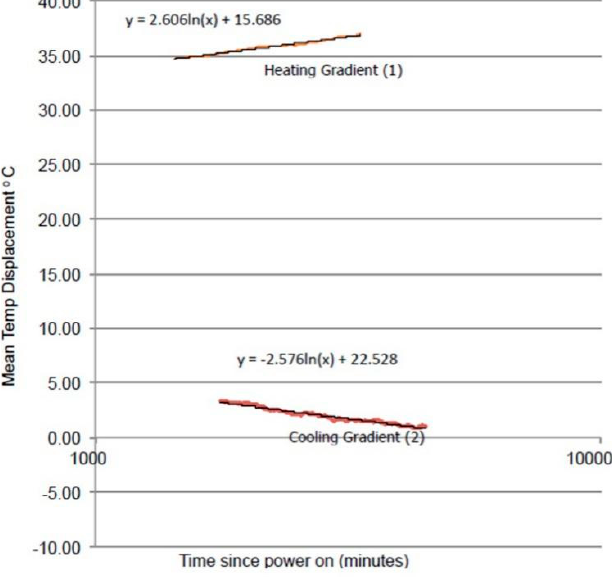
Figure 7. ln(t) vs. average temperature in the hot / cold